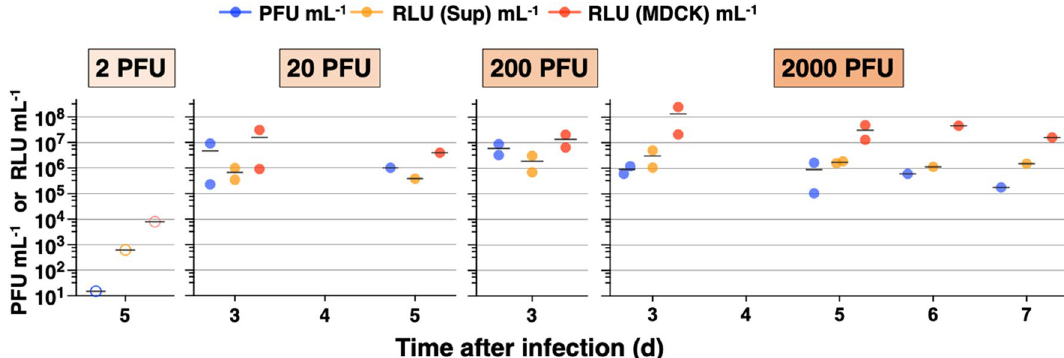
Figure 9. In vitro measurements on BALF samples to compare plaque vs luciferase assay. BALF was collected during the terminal procedure from 1 mouse or 2 mice at each inoculation dose (2, 20, 200, or 2000 PFU) of IAV and evaluated with in vitro plaque assay ( PFU mL −1 ) and luciferase assay on supernatant (RLU (Sup) g −1 ), and MDCK cells (RLU (MDCK) g −1 ). Mean, black line. Hollow circles indicate measurements that were below the limit of detection of BALF samples for plaque assay (15 PFU mL −1 ) or luciferase assay on supernatant (625 RLU (Sup) mL −1 ) or MDCK cells (8000 RLU (MDCK) mL −1 ). PFU plaque forming units, RLU relative luciferase units, Sup